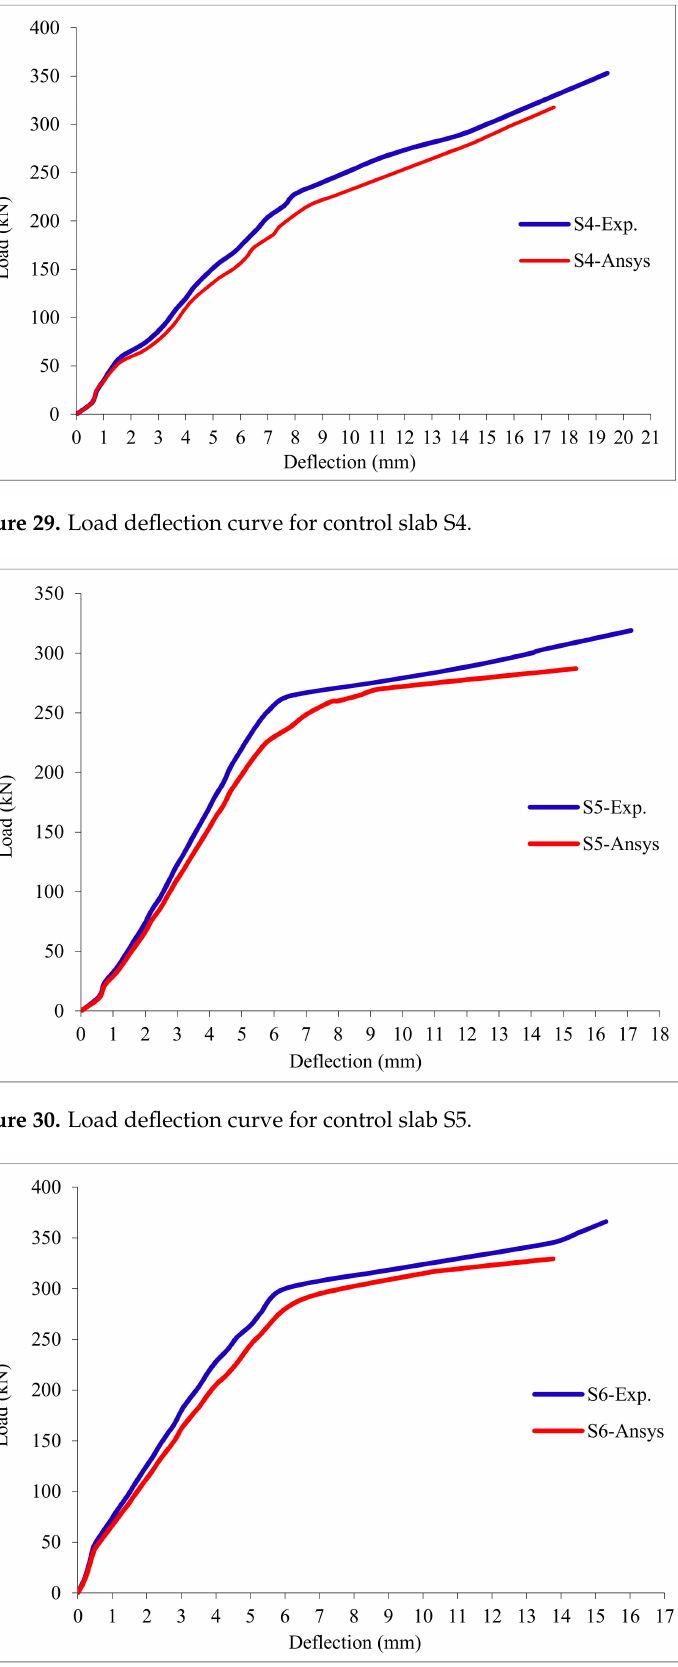
Figure 31. Load deflection curve for control slab